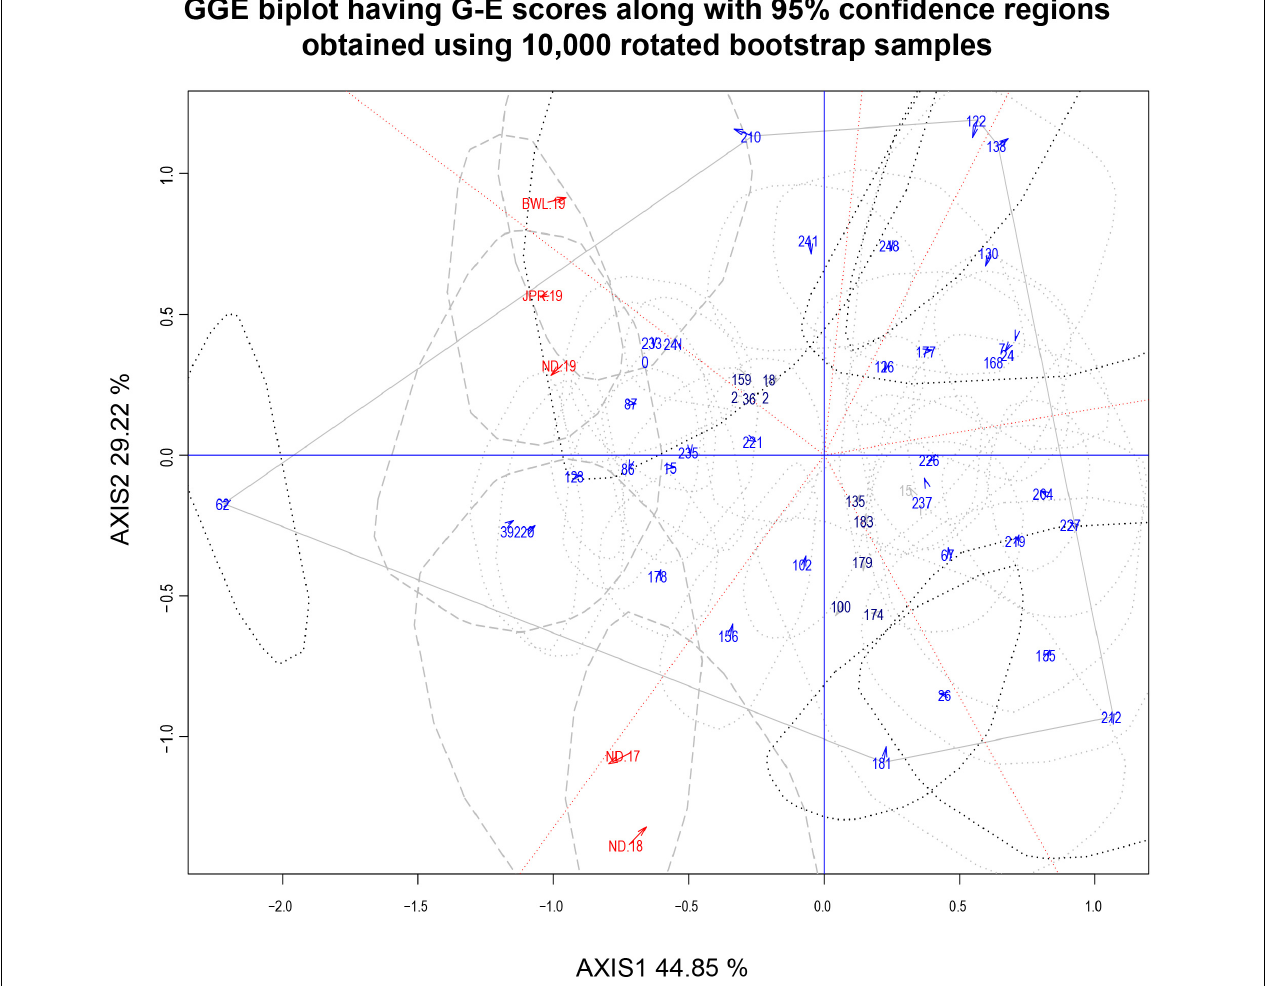
FIGURE 9 | Which-won-where biplot view of 43 genotypic scores and five environmental scores constructed along with the 95% confidence regions using 10,000 rotated bootstrap samples. There was heritability-adjusted scaling of data where the environment standardized data were multiplied by the heritability in each environment (transform = HA), and data were centered by means of the environments (centering = 2). The biplot was based on “row metric preserving” [singular value partition (SVP) = 1], which means that the singular values were partitioned into the genotype eigenvectors for visualizing the correlation among genotypes. Numbers correspond to genotypes as listed in Supplementary Table 1 . Environment: ND-17, New Delhi-2017; ND-18, New Delhi-2018; ND-19, New Delhi-2019; BWL-19, Bawal-2019; JPR-19,